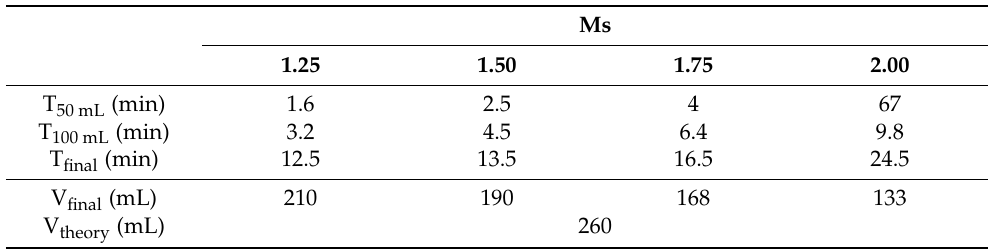
Table 4. Gas generation under different activator moduli (Ms). (paste = 150 g, Na 2 O% =